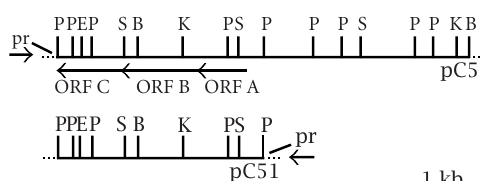
Figure 2: Physical map of pC51 plasmid DNA and its alignment with the pC5 restriction map. Dots represent the plasmid vector pHLD 69 . Symbol; pr: lac Z promoter, and the arrow indicates its orientation. Restriction endonuclease sites are abbreviated as fol- lows; B, BamHI; E, EcoR I; K, Kpn I; P, Pst I; S, Sph I. The ORFs A, B, and C were identified on the basis of sequence homologies, and encode for GGPP synthase, phytoene desaturase and phytoene synthase, respectively [6].